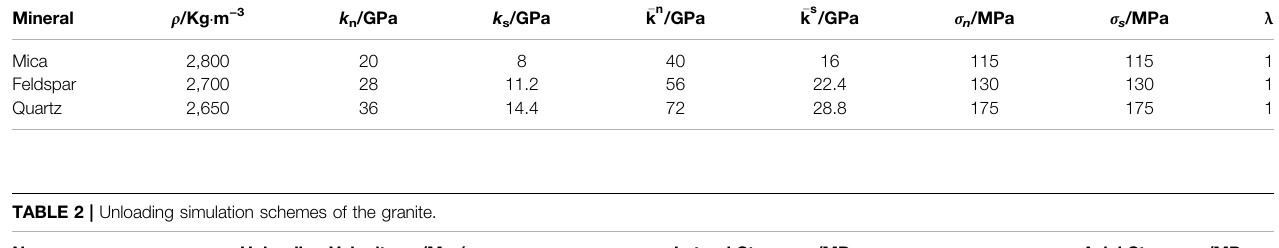
TABLE 1 | Microstructure model parameters of granite minerals (Zhang et al., 2019). Mineral